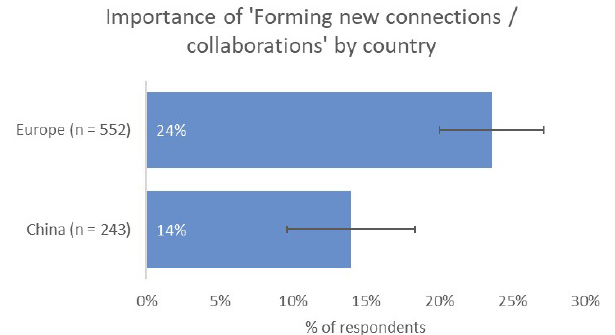
Figure 15. Relative importance of reaching a target community between the demographics considered.